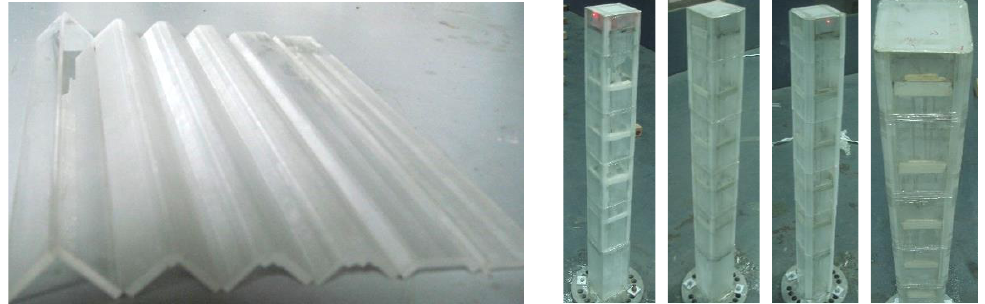
Figure 4. Some photos of the MDOF model and coated strips for adjusting the chamfer ratio. Table 1 shows the structural parameters of different chamfer models. In Table 1, n 0 is the primary frequency of each model, M is equivalent mass, ξ is structural damping ratio, Sc is Scruton number, and R c is the chamfer ratio. As seen from Figure 4 and Table 1, the cross- sectional shapes of each model are smooth from top to bottom and the structural parameters of each model have little difference, which indicates that the above method of adjusting the chamfer ratio is satisfactory. As the structural parameters of all these test cases are the nearly same except the chamfer ratio, it can be reasonably stated that the difference in wind-induced vibration between these cases was caused by the differences in chamfer ratio. Table 1. The structural parameters of models with different chamfer ratio.